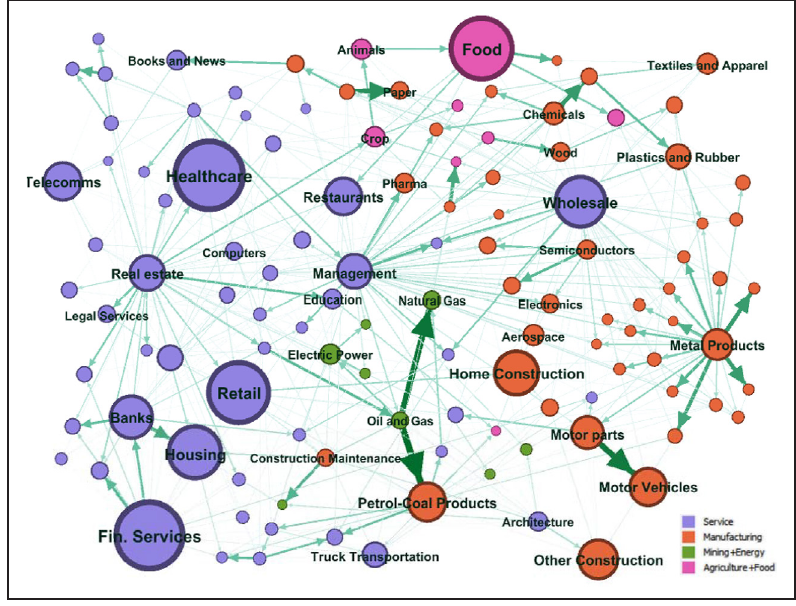
Figure 2 Input–output linkages between US sectors. The graph shows linkages between the US sectors, to illustrate the concept of upstream and downstream sectors. The arrows show the direction of flow for materials; so for example, one can see that Electric Utilities are downstream of the coal- and oil-mining sectors. Simi- larly, the figure illustrates how the food manufacturing sector is upstream of res- taurants but downstream of crop and animal farming (Data from the BEA 2002 Benchmark Input–Output